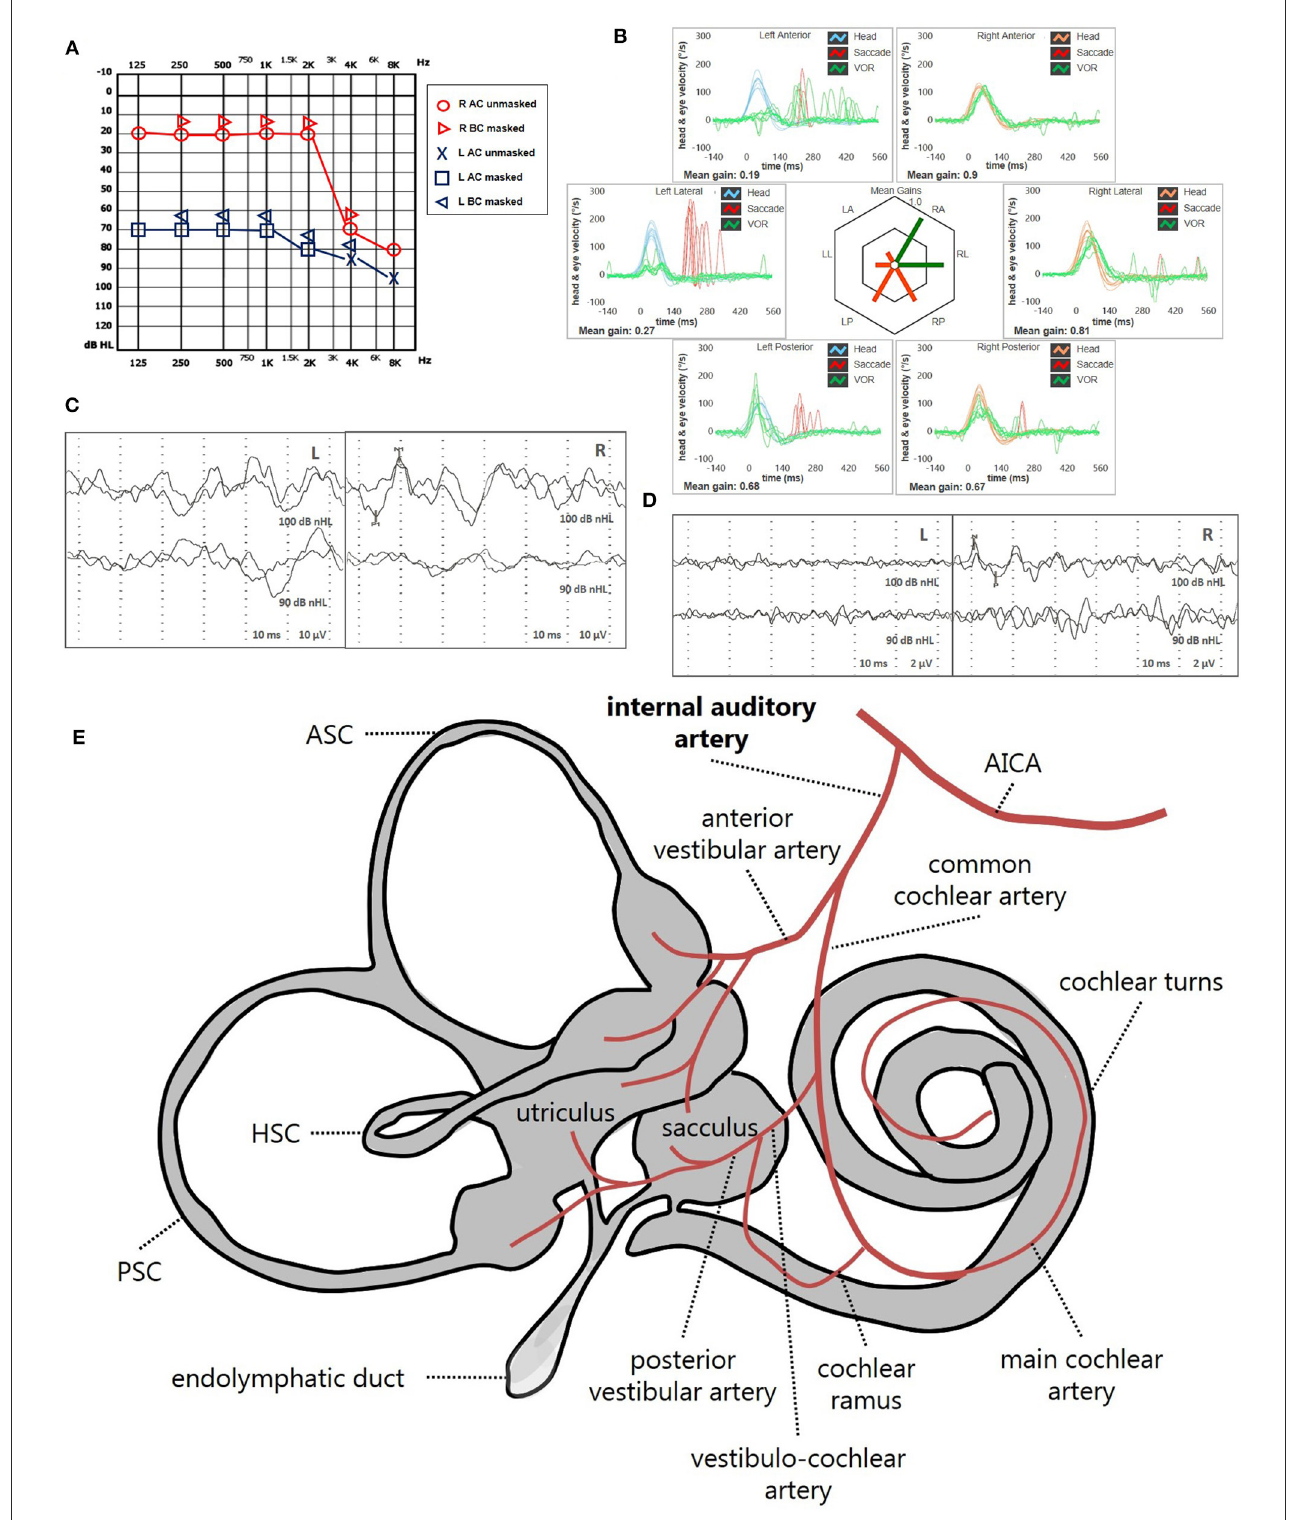
FIGURE13 Presenting scenario of patients #59 with an instrumental lesion pattern consistent with an ischemic damage in the territory mainly supplied by the left IAA (see also the Supplementary Video 3). (A) Pure-tone audiometry exhibiting severe flat sensorineural HL on the left side. (B) vHIT showing VOR-gain impairment for all the left SCs with mainly overt saccades. cVEMPs (C) and oVEMPs (D) revealing absent potentials on the left side and normal responses on the right (AR = 100%). (E) Labyrinthine receptors mainly supplied by the IAA are represented in gray. AC, air-conduction; AICA, anterior-inferior cerebellar artery; ASC, anterior semicircular canal; BC, bone-conduction; CCA, common-cochlear artery; cVEMPs, cervical vestibular-evoked myogenic potentials; HSC, horizontal semicircular canal; L, left; LA, left anterior; LL, left lateral; LP, left posterior; oVEMPs, ocular vestibular-evoked myogenic potentials; PSC, posterior semicircular canal; SC, semicircular canal; R, right; RA, right anterior; RL, right lateral; RP, right posterior; vHIT, video-head impulse test; VOR, vestibulo-ocular